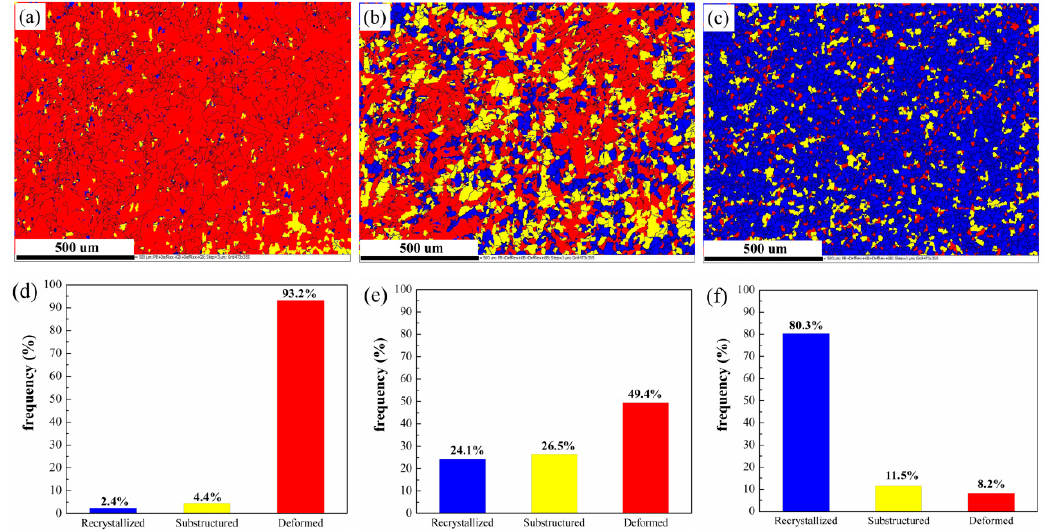
Figure 6. Inverse pole figure maps ( a – c ) and grain size distribution maps ( d – f ) of the deformed specimen at various true strains: ( a , d ) ε = 0.105; ( b , e ) ε = 0.223; ( c , f ) ε = 0.916.